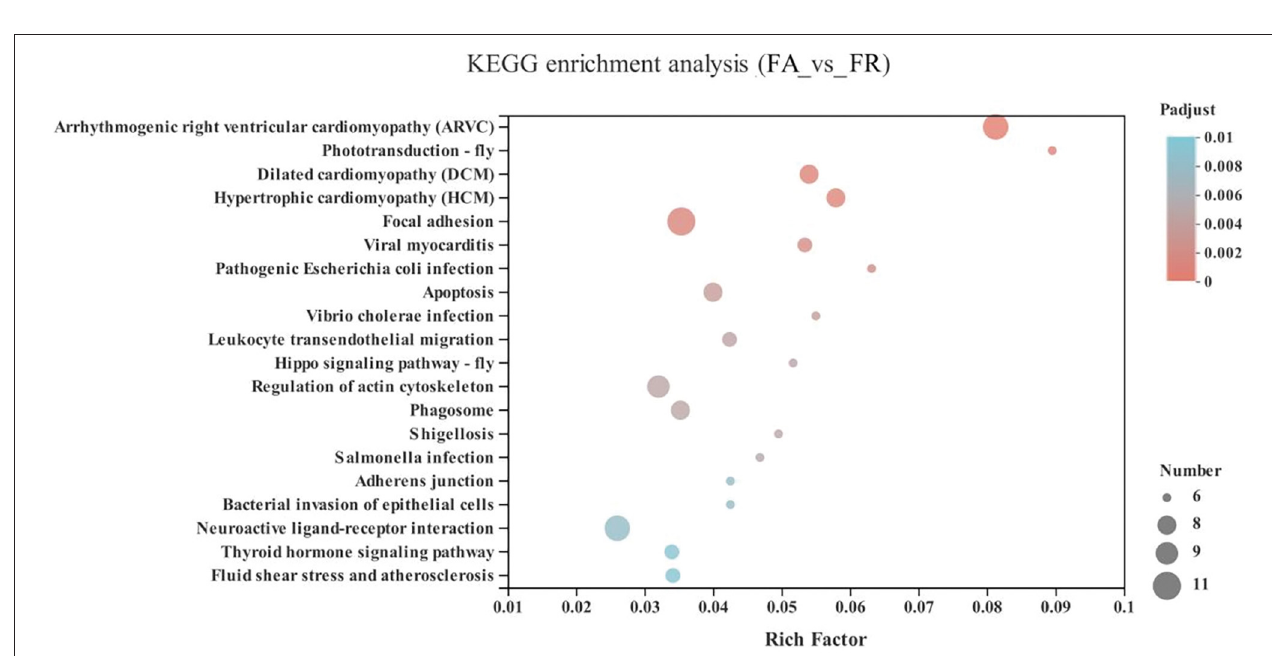
FIGURE 5 | KEGG pathway enrichment analysis of differentially expressed genes (DEGs) between SA and FR groups. SA, slow-growing dual-purpose chickens ad libitum ; FR, fast-growing broilers feed restriction.